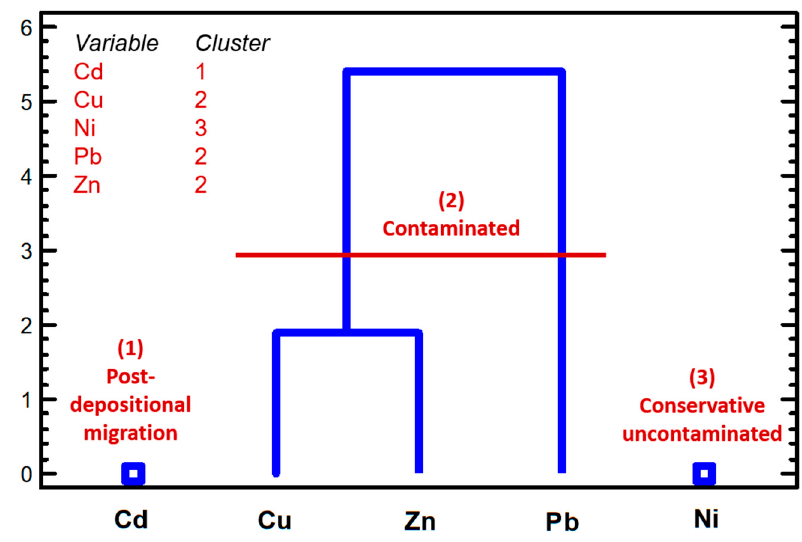
Figure 4. Cluster analysis (median method, squared Eucliean distance) performed over the total extractable contents for each element in the studied core.